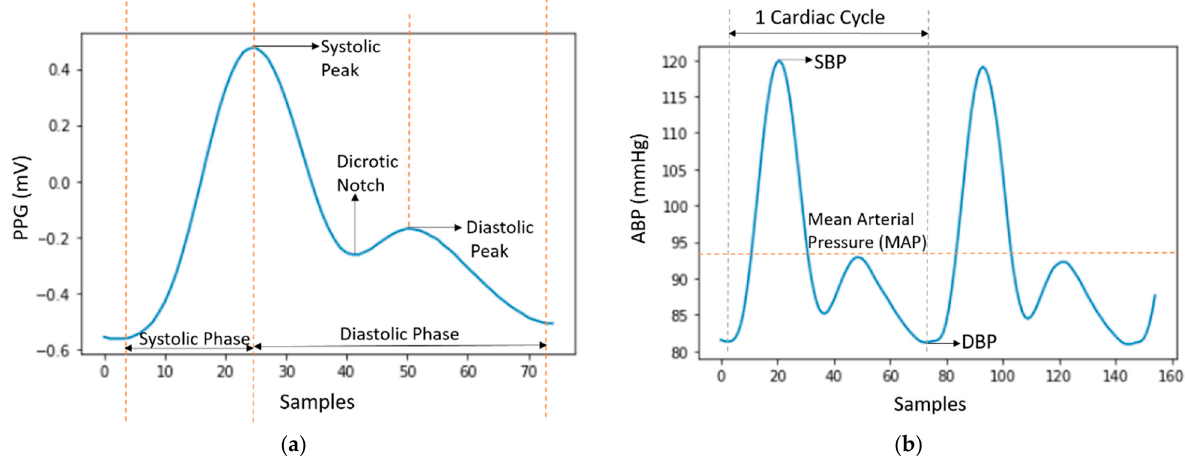
Figure 2. ( a ) Single PPG signal; ( b ) ABP signal with properties.